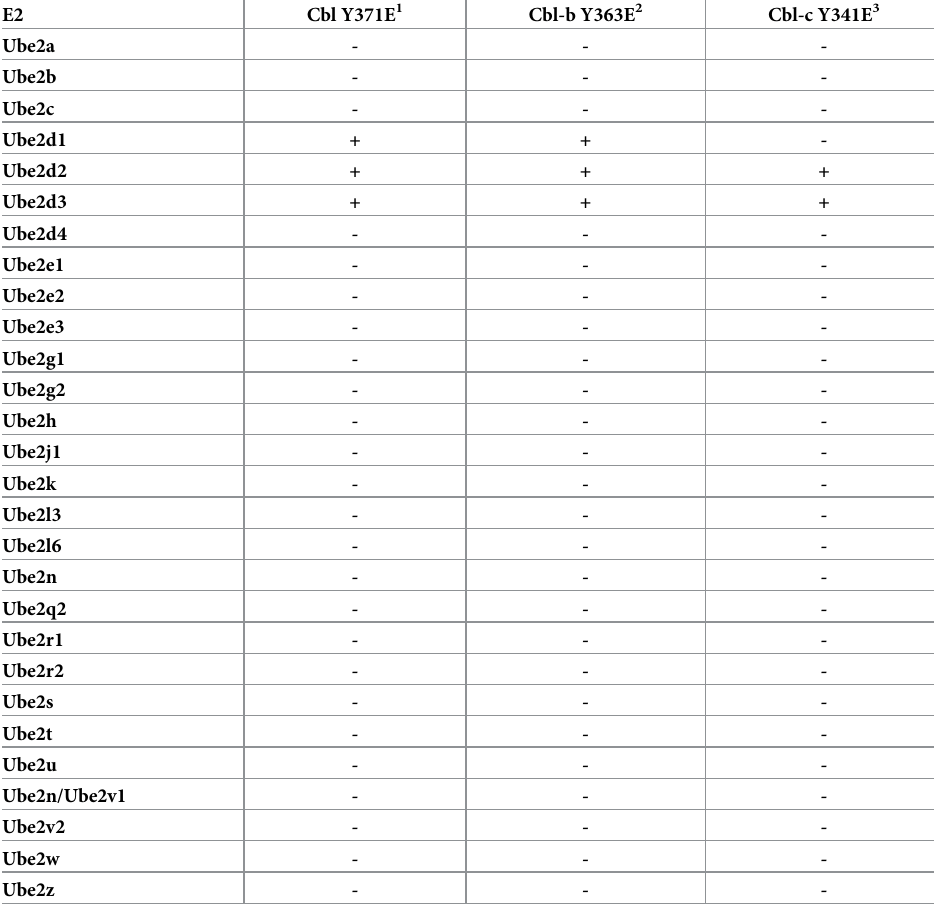
Table 1. E2s tested for activity with Cbl proteins in vitro .